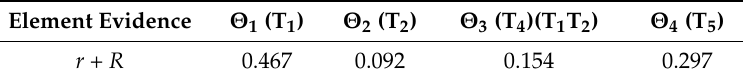
Table 6. First fusion result.